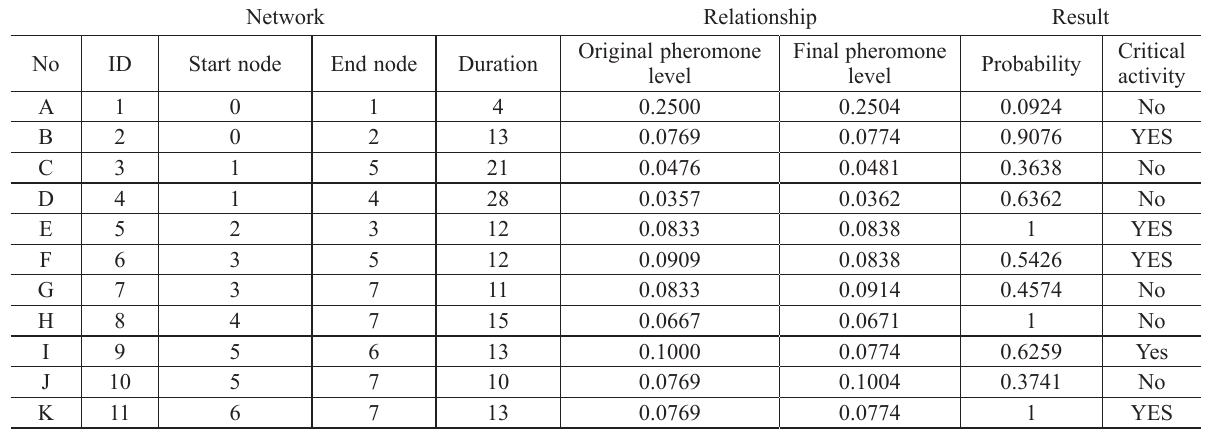
nated by the trial run of CSAM-ACO under a real case.